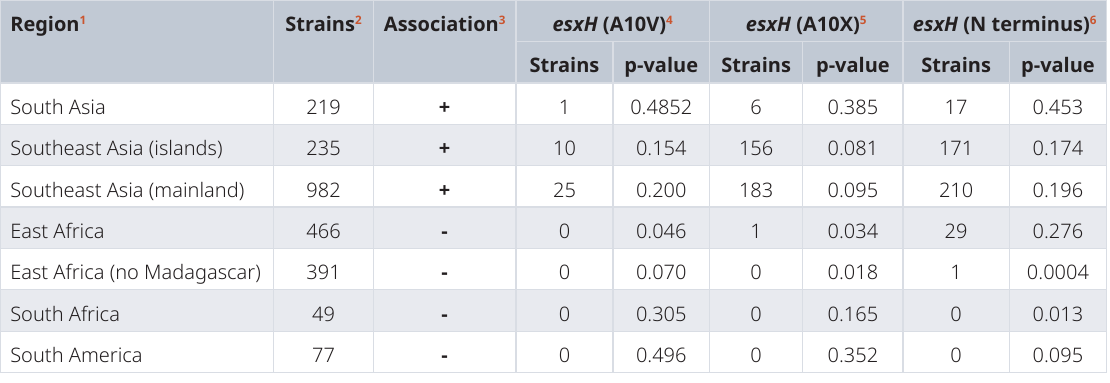
Table 1. Results of the test of association between haplotypes of the N-terminal esxH epitope and the geographic region of origin. Region